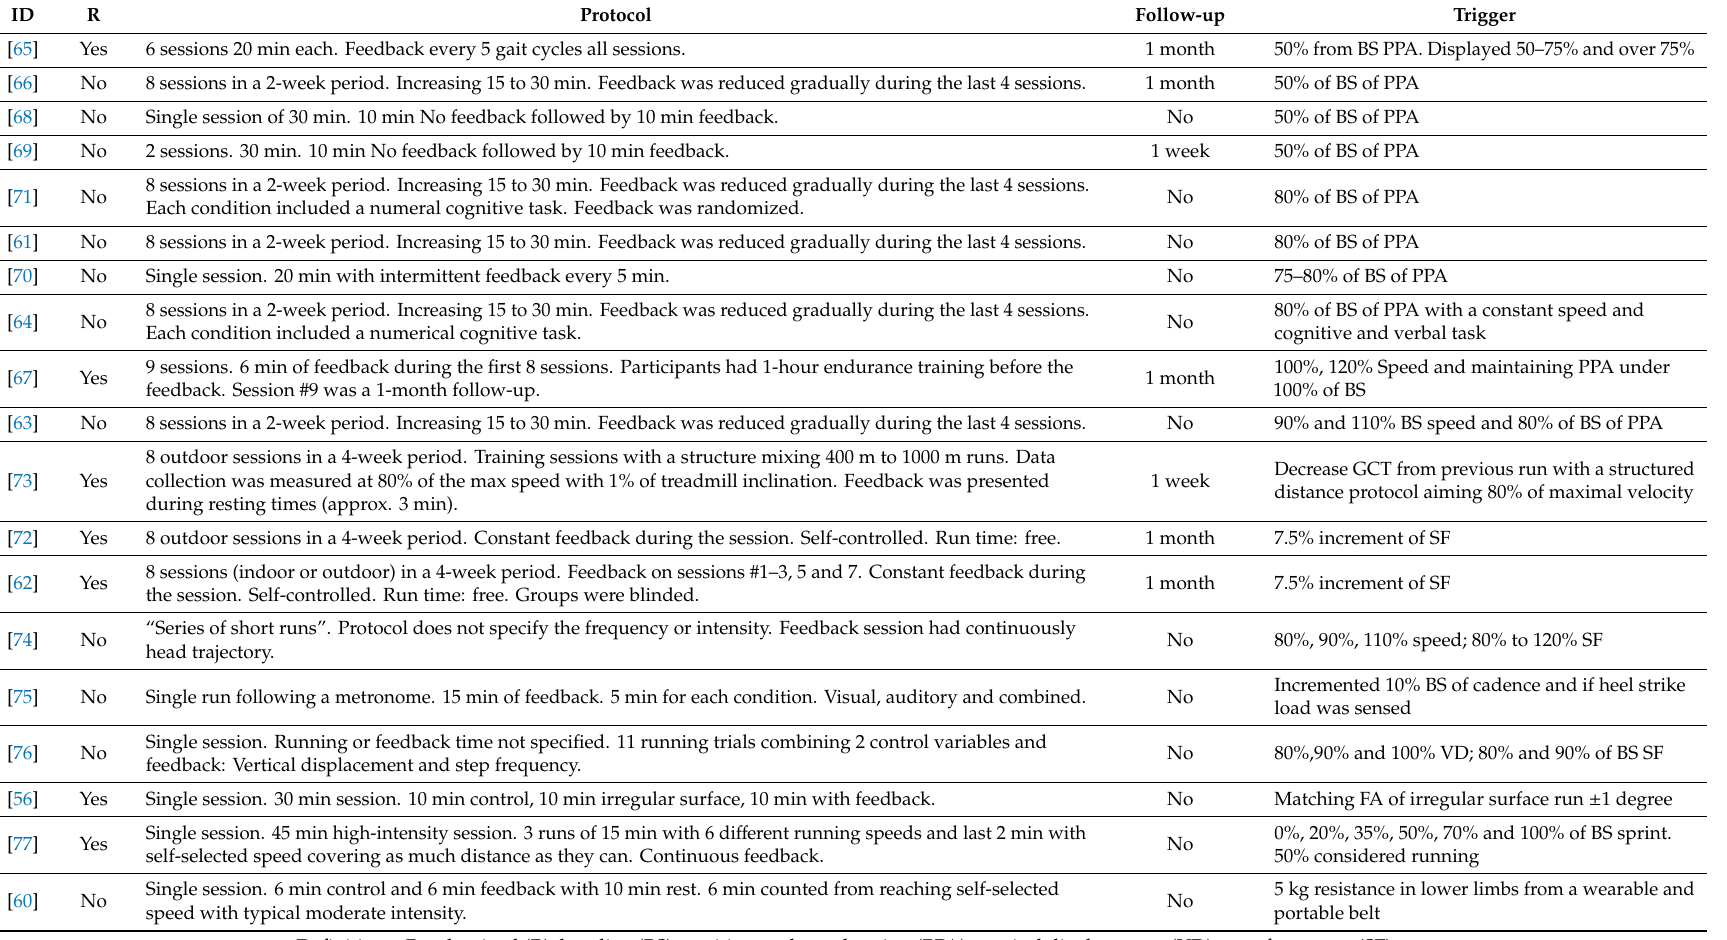
Table 4. Protocol and parameter that triggers feedback